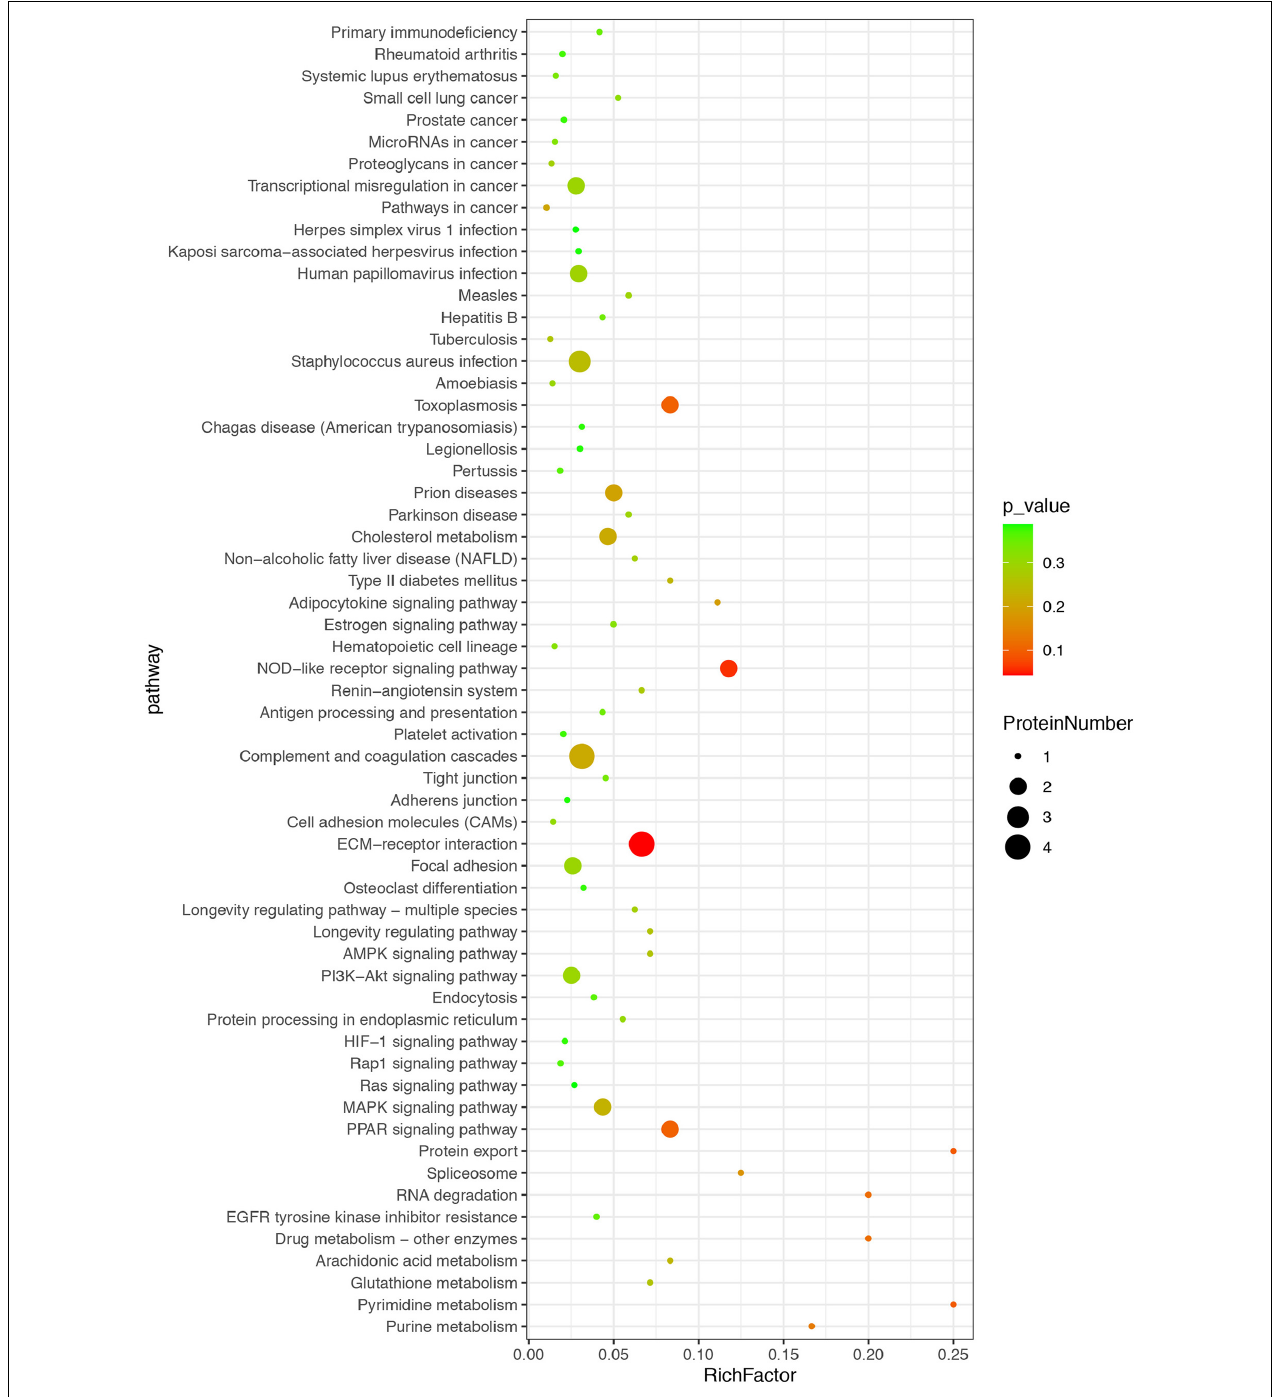
FIGURE 4 | Kyoto Encyclopedia of Genes and Genomes (KEGG) enrichment analysis of differential proteins. The differentially expressed proteins were classified based on KEGG database. Each bubble represents one pathway, and the size of the bubbles reflects the protein number in each pathway. Bubble color represents the p-value of